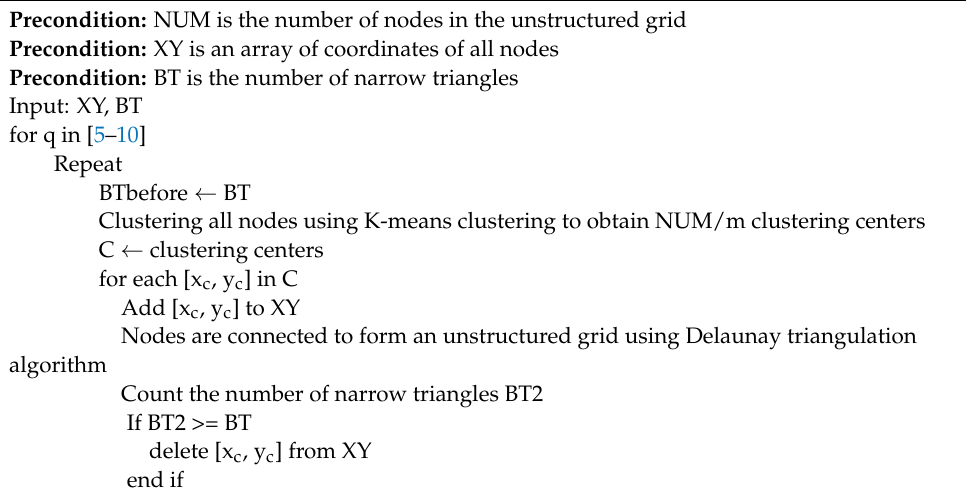
Algorithm 2 Further Optimization of Unstructured Grid Based on K-Means